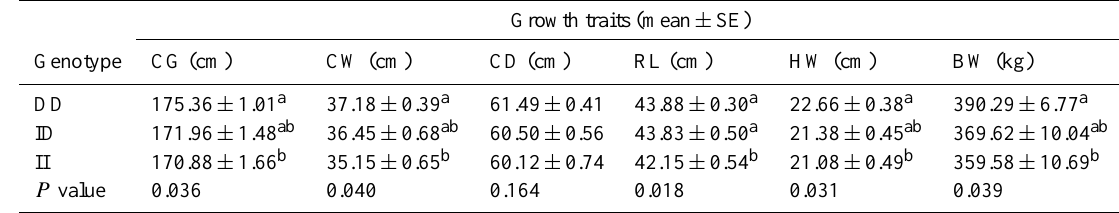
Table 3. Association of the 17 bp indel within the SMAD3 gene and growth traits of QC cattle.